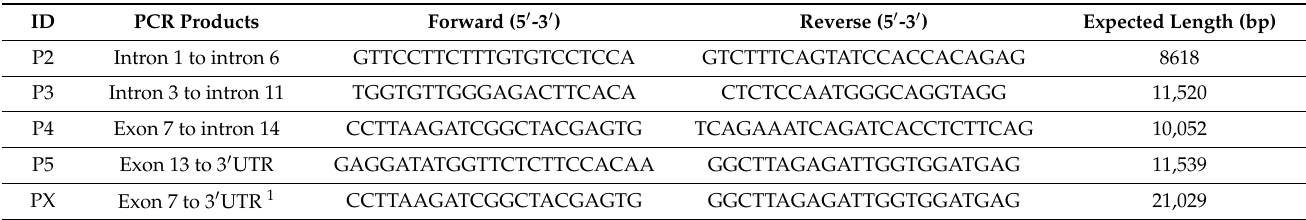
Table 2. The primer pairs targeting parts of LDLR